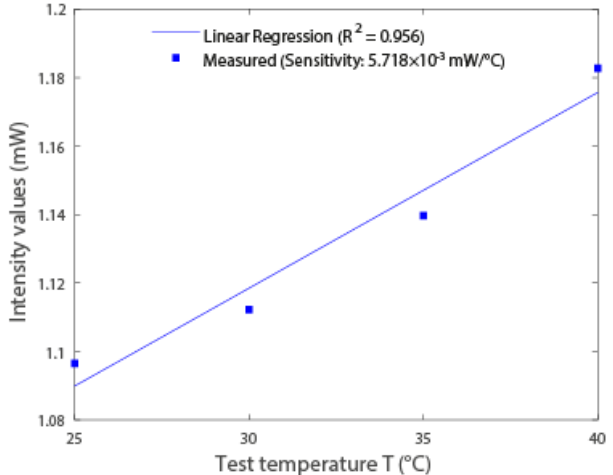
Figure 6. Intensity results (normalized between the minimum and maximum intensity values acquired in each test) in relation to temperature